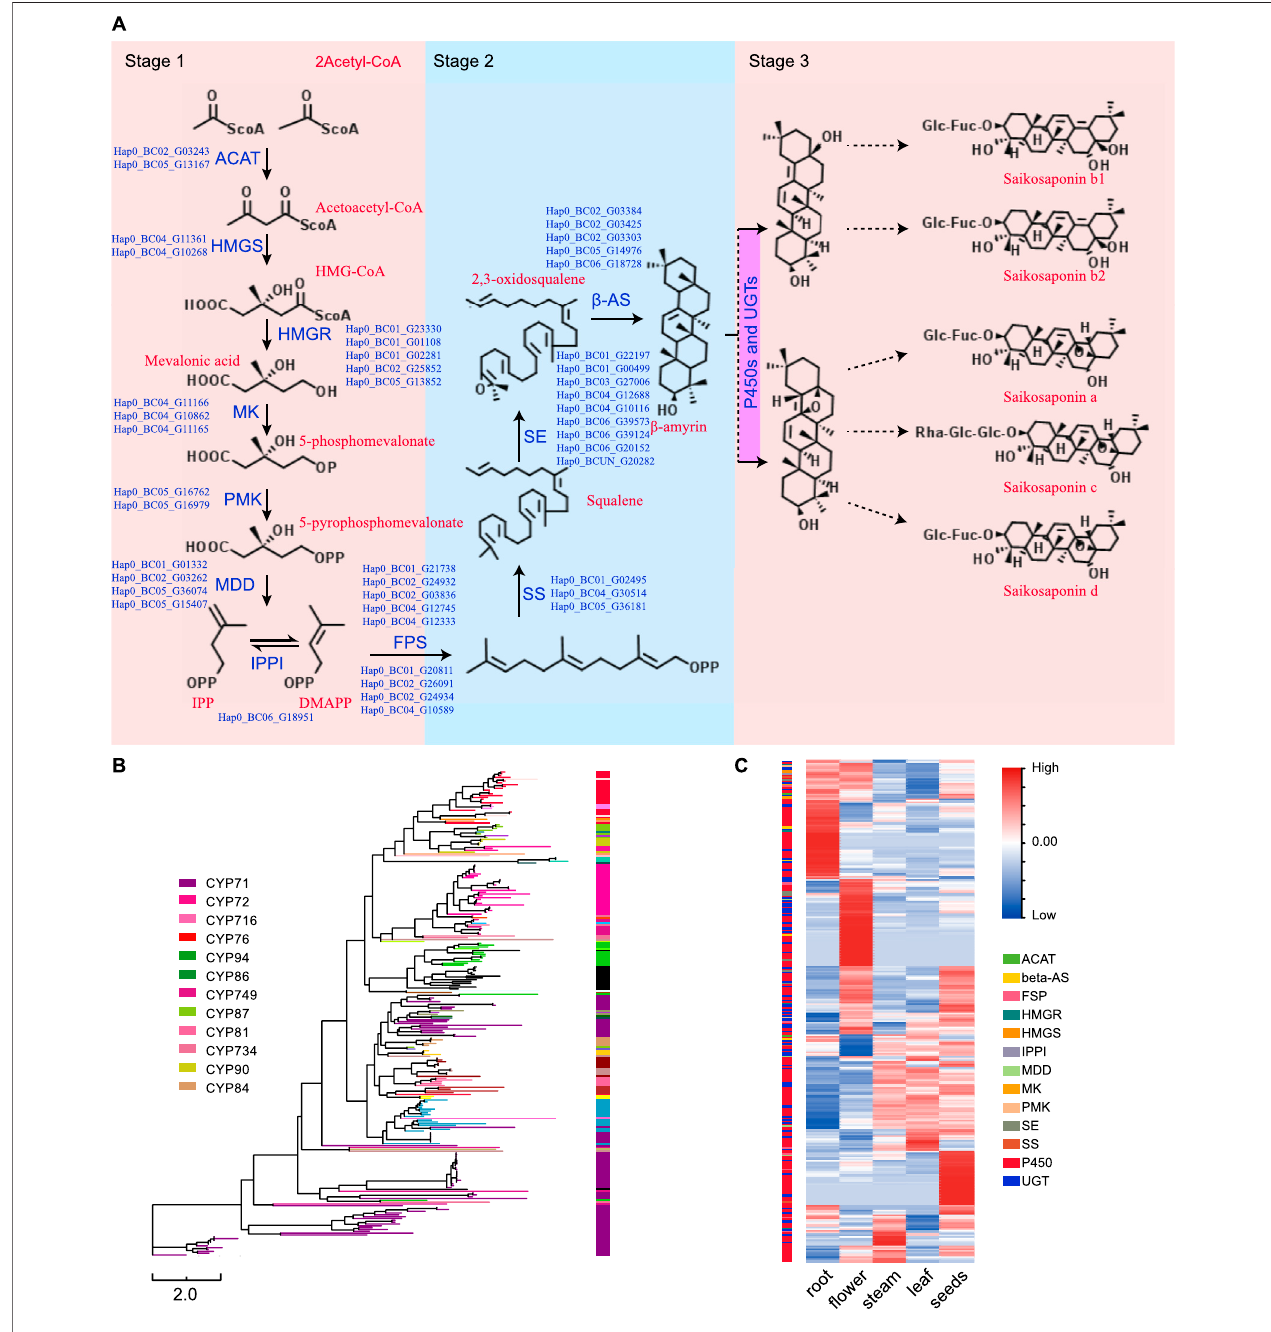
FIGURE 5 | Identi fi cation and analysis of the genes involved in the biosynthesis of saikosaponins. (A) The SS biosynthetic pathway. (B) A neighbor-joining phylogenetic tree including the P450 protein sequences. Each color represents a P450 family or subfamily. (C) Heat map showing the expression levels of the P450s, UGTs, and other genes involved in the biosynthesis of saikosaponins based on the RNA-Seq data from the root, stem, leaf, fl owers, and seeds.